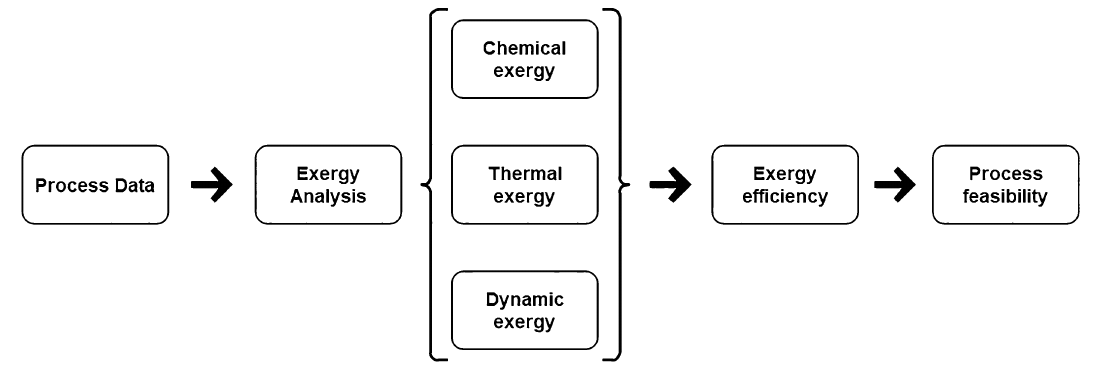
Fig. 1 Methodological representation of exergy analysis